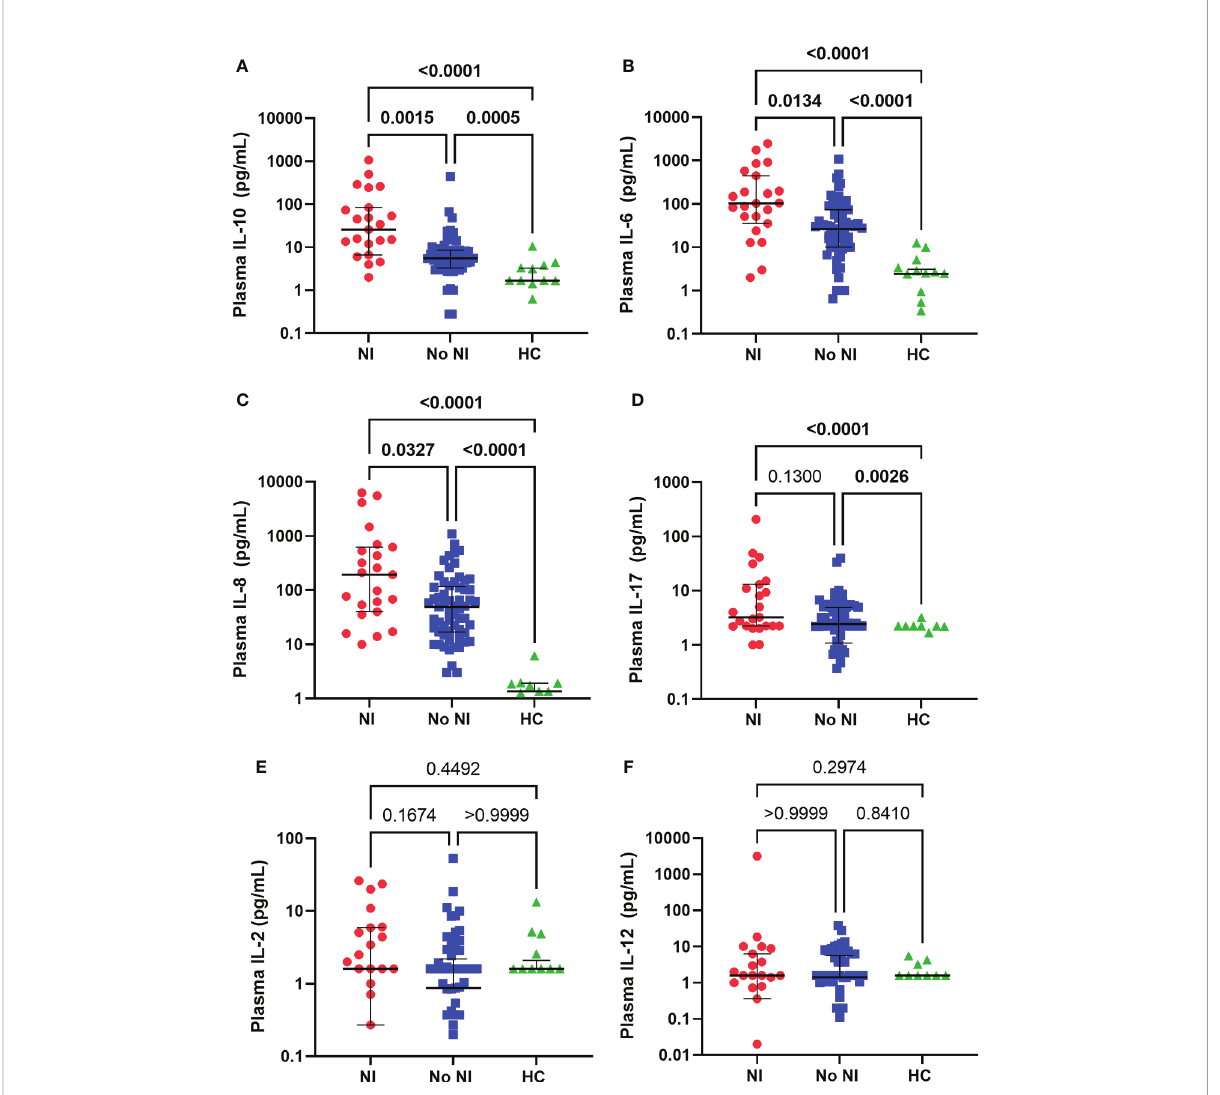
FIGURE 1 Plasma cytokines levels within the fi rst 72 hours following pediatric thermal injury. Burn injury, regardless of infection (NI, n=23 and No NI, n=61) signi fi cantly decreased median plasma levels of IL-10 (A) , IL-6 (B) , IL-8 (C) , and IL-17 (D) compared to healthy controls (n=17, except IL-8 n=11). Subjects who went on to develop NI had higher plasma levels of IL-10 (A) , IL-6 (B) , and IL-8 (C) compared to those who recovered from burn injury without developing an infection. There were no signi fi cant differences in the plasma levels of IL-2 (E) and IL-12 (F) between groups in the fi rst 72 hours. Statistical analysis was performed using one-way ANOVA plus Dunn ’ s test. Lines represent median and interquartile range; dots represent the individual data points. NI, nosocomial infection (red); No NI, no infection (blue); HC, healthy control